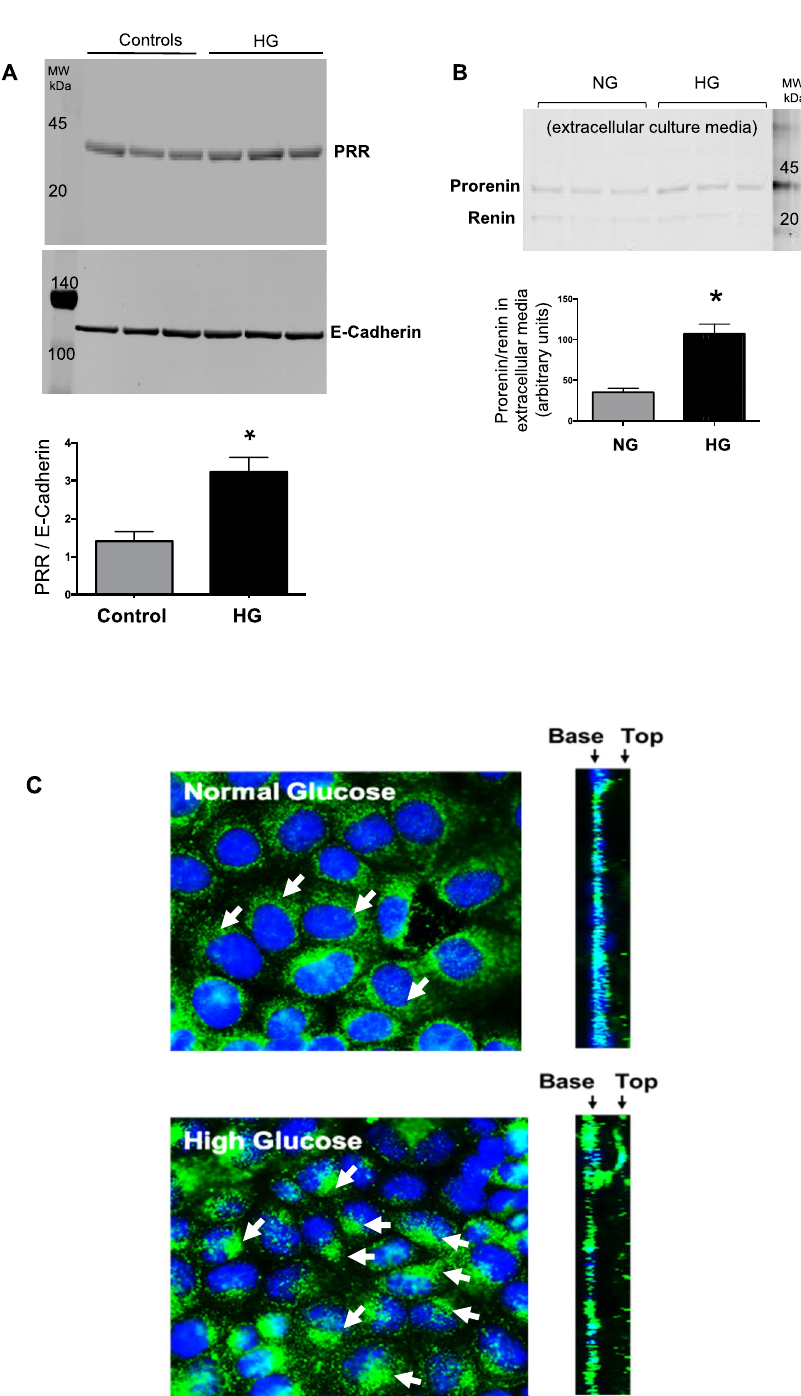
Figure 8. In vitro studies in M-1 cells showing the effect of high glucose conditions on PRR translocation to the cell plasma membrane. ( A ) Membrane fractions from M-1 cells showed increased levels of PRR after 6 h of HG treatment (n = 3). ( B ) Representative image of an immunoblot from supernatant cell culture media after 50-fold concentration showing increased prorenin and renin abundance after HG treatment (n = 3). ( C ) PRR immunofluorescence in NG and HG conditions. In NG conditions the PRR is localized mainly in the perinuclear area (arrows). After 1 h of HG incubation, the PRR showed high abundance at the apical side of the cell (arrows and insert at right). ( D – F ) Angiotensinogen fluorescence resonance energy transfer (FRET) experiments. Pellets of protein fractions were incubated with 10 nM prorenin for 30 min at 37 °C. Ten nanomolar trypsin-activated prorenin was used as a positive control and renin inhibitor Ac-HPFV-(Sta)-LF-NH2 was used as a negative control. Fluorescence intensity was read using the Synergy 2 Multi-Detection Microplate Reader (BioTek) before and after addition of the substrate (angiotensinogen, AGT) for 110 min. The final fluorescence intensity value of 5-FAM/QXL versus time was plotted and the variations of the fluorescence intensities of NG (green line) and HG (blue line) were compared to positive (trypsin activated prorenin, brown line) and negative control (in the presence of renin inhibitor, orange line), as an indicator of the amount of final product of the renin enzymatic activity. Values were corrected by the amounts of protein concentration quantified in the membrane fractions (n = 3). *P < 0.05; ***P < 0.001. ( D ) was drawn by first author using powerpoint software MICROSOFT OFFICE 2019 (https:// www. office.